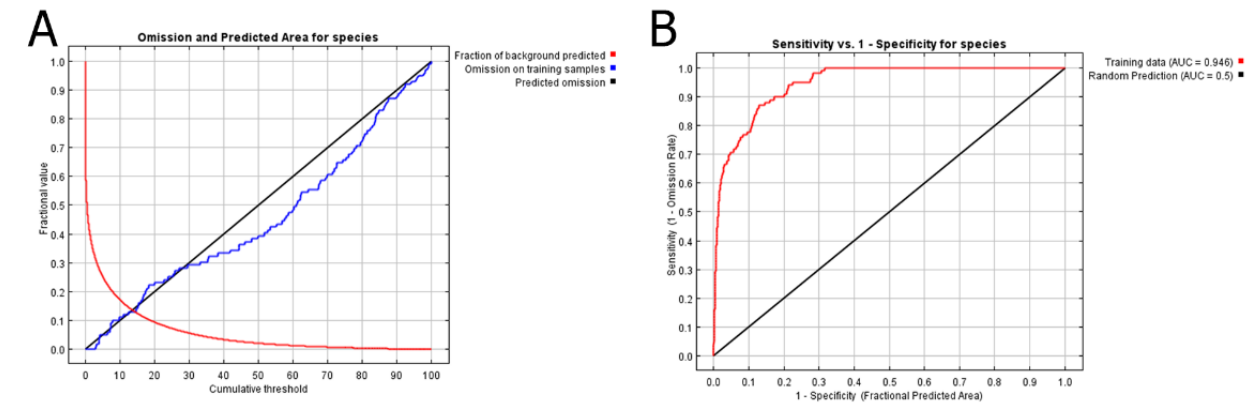
Figure 2. Predictions of Phytoseiulus persimilis : ( A ) omission rate, ( B ) ROC curve and AUC value.